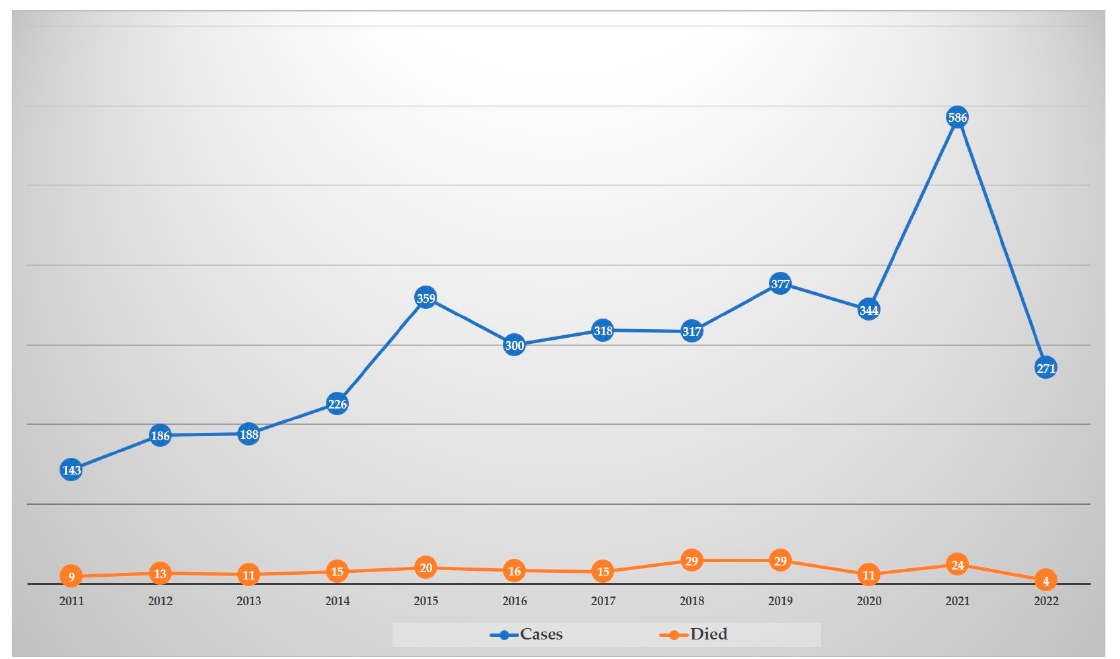
Figure 1. Human S. suis cases in Thailand 2011–2022 reported in R506 system by the Bureau of Epidemiology, Department of Disease Control, Ministry of Public Health. For 2022, data are provided only up to September.